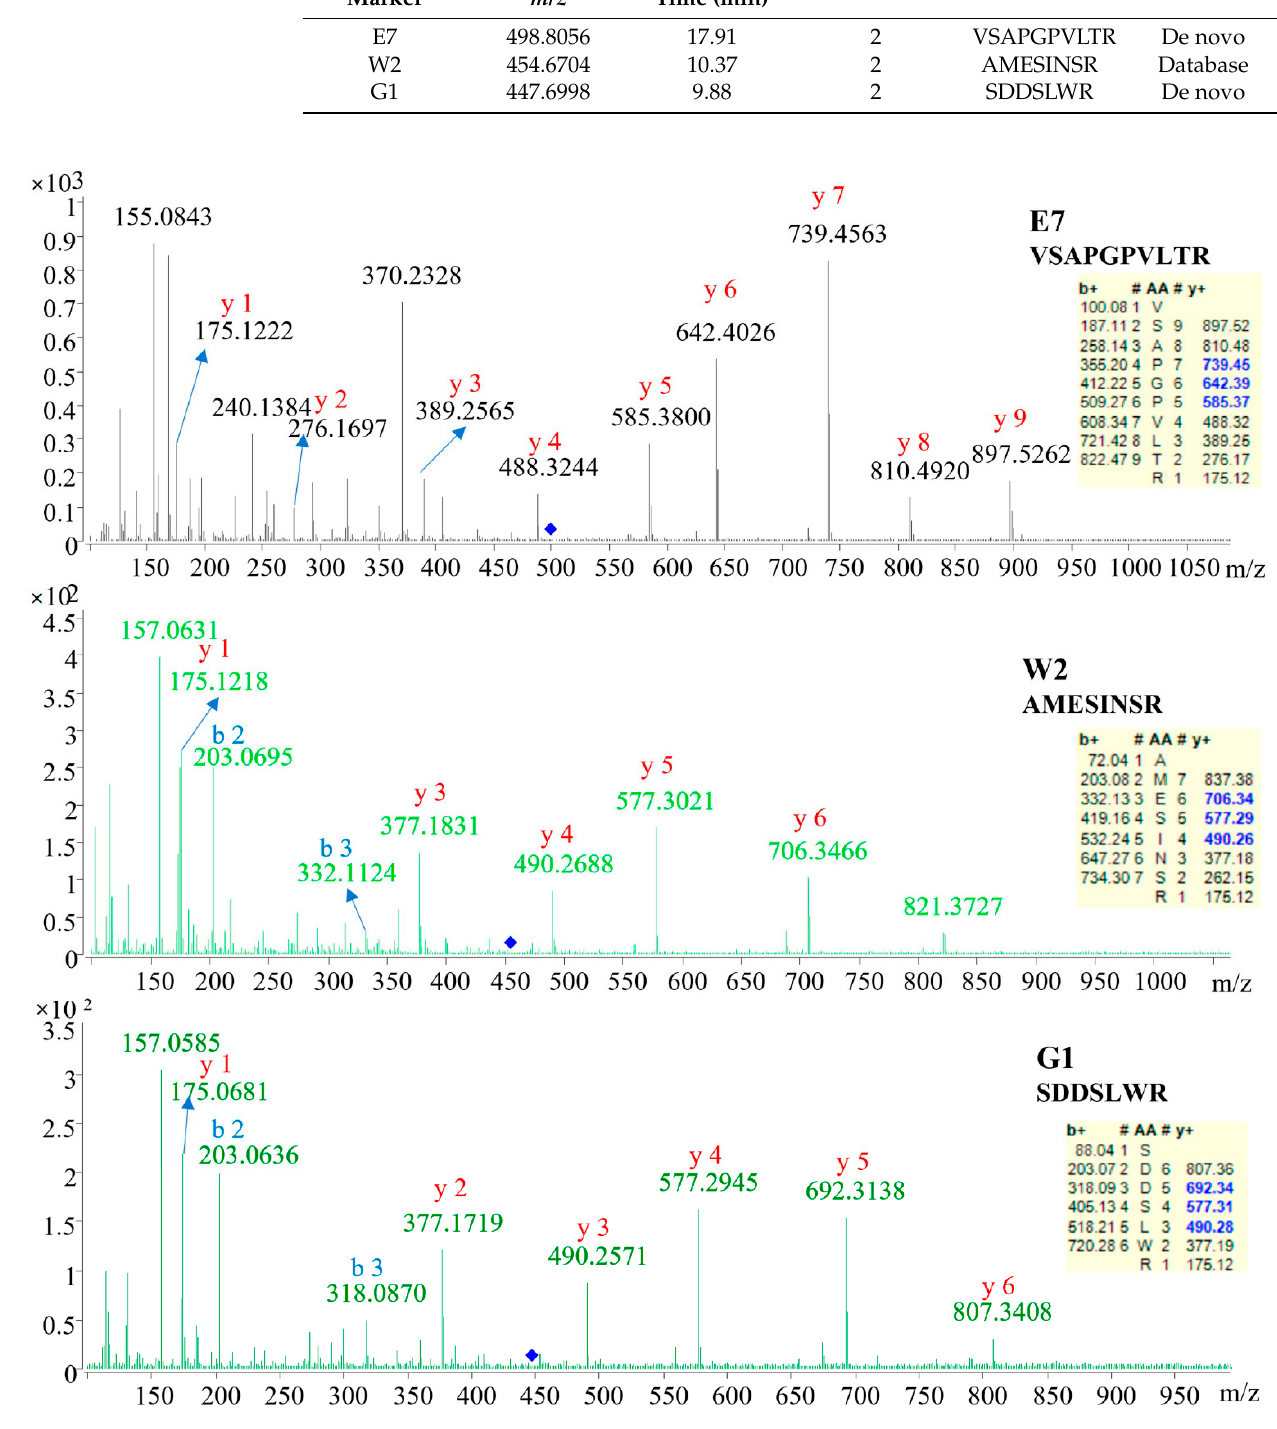
Figure 2. The LC-ESI-MS/MS spectra of ions corresponding to the identified peptide markers. Table 2. The peptide markers identified by database searching and de novo sequencing.